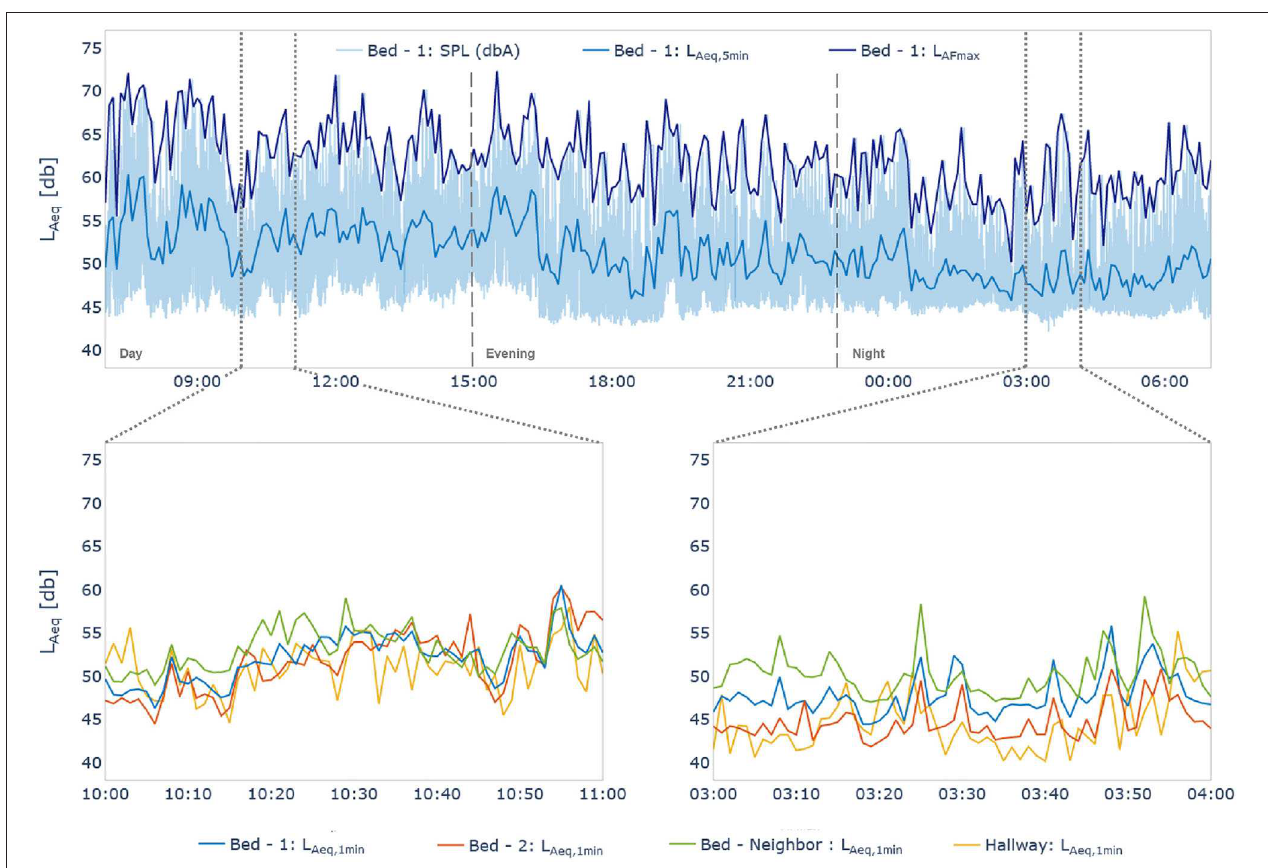
FIGURE 4 | (Top) 24-h overview of sound pressure levels measured by the class II device positioned over bed 1 ( Figure 3 ). Dark blue shows the L FAmax, and the light blue trend shows the L Aeq calculated over 5-min. The shaded area represents the raw sound pressure levels (SPL). (Bottom) Sub-figures show 1-minL Aeq values for all devices (one class I, three class II) illustrating the different levels of alignment between the devices over two 1-h snapshots. Vertical dashed lines (15:00 and 23:00) indicate shift